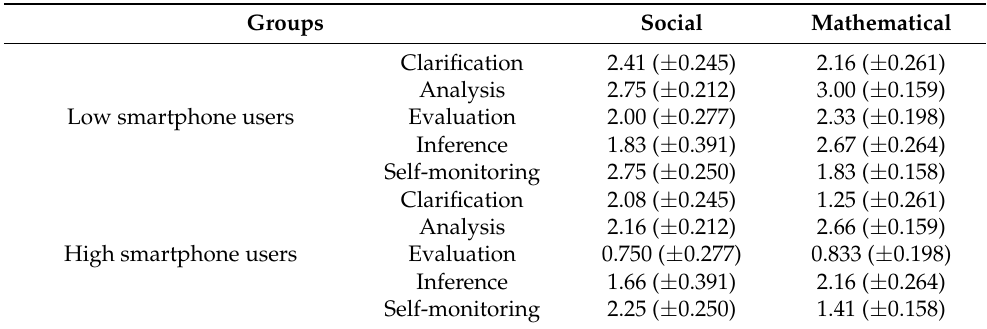
Table 5. Descriptive statistics of the mean of correct replies and standard deviations in each phase of critical thinking.